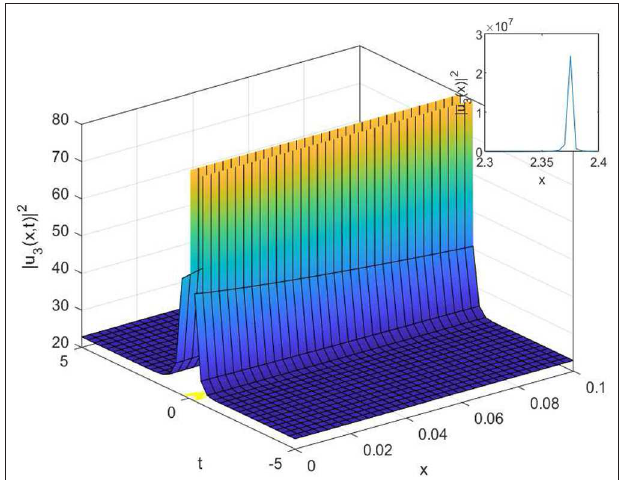
FIGURE 5 | 3D, 2D, and contour surfaces of Equation (34) where c